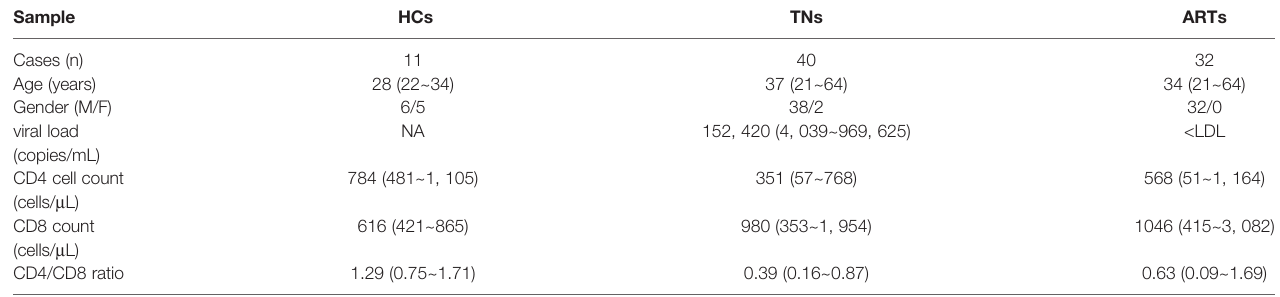
Data were expressed as the median (range). HCs, healthy controllers; TNs, treatment naïve patients; ARTs, patients under antiretroviral therapy; M, male; F, female. NA, not applicable; LDL, lower detection